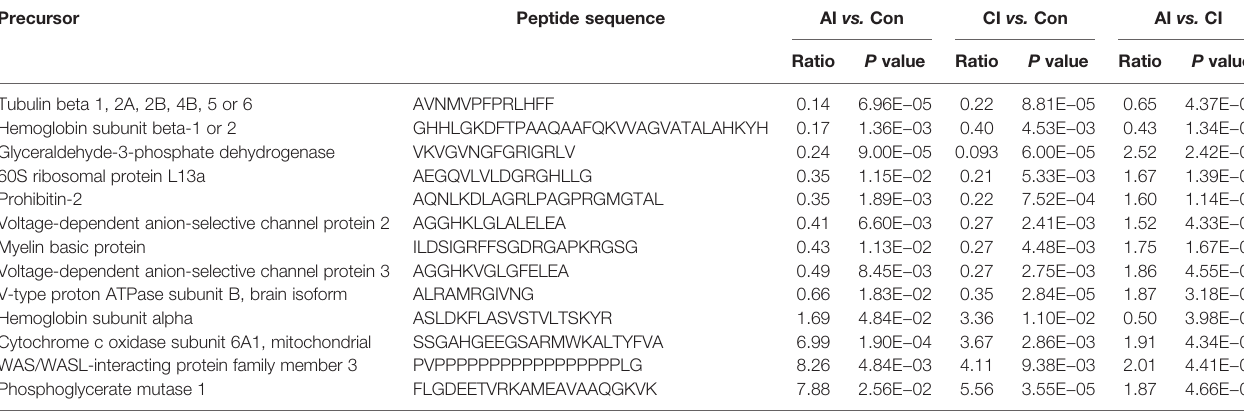
TABLE 1 | List of differential expressed peptides identi fi ed among all comparison pairs. Precursor Peptide